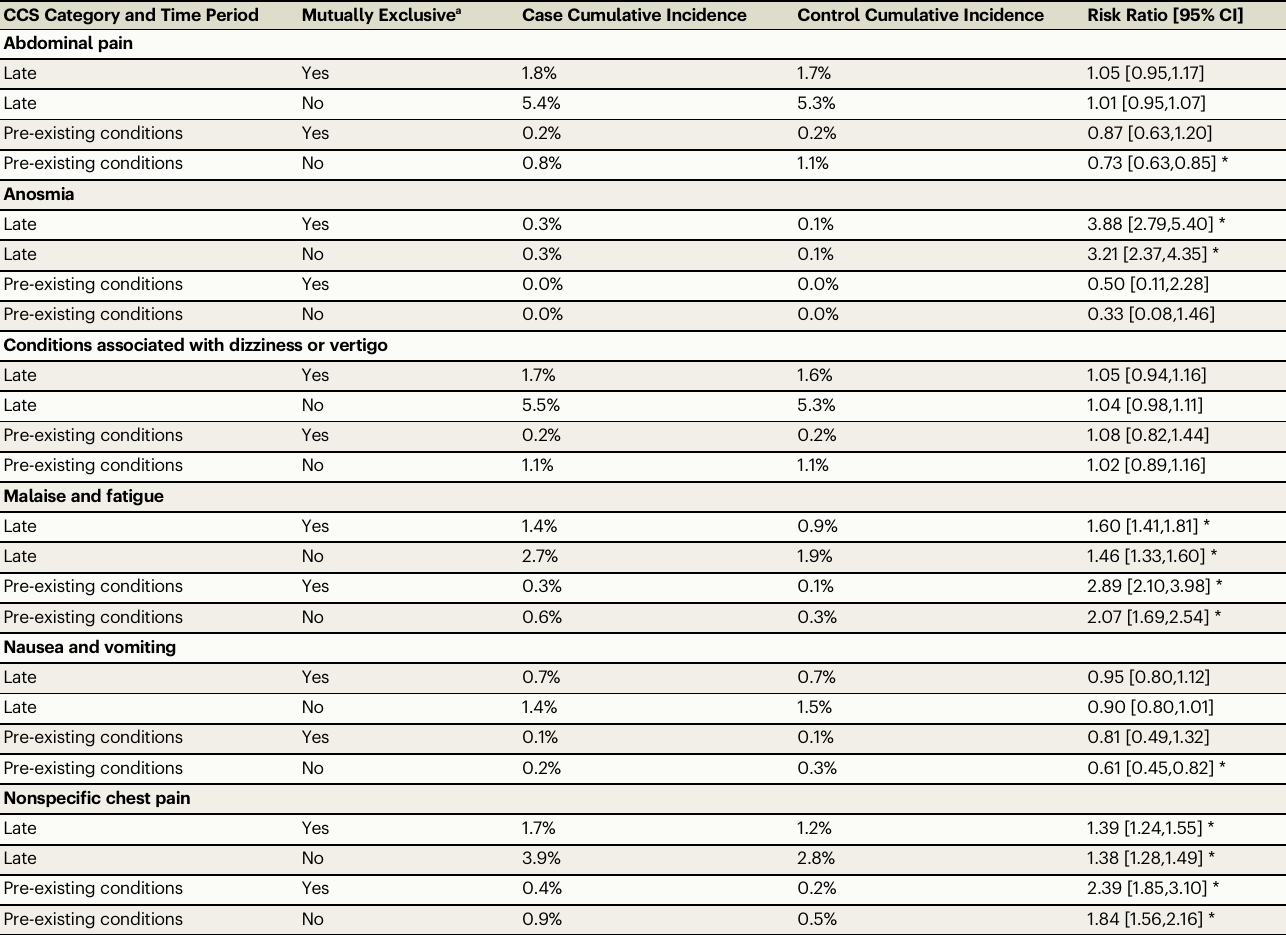
Table 6 | Sensitivity analysis - risk and cumulative incidence of symptom-based CCS categories CCS Category and Time